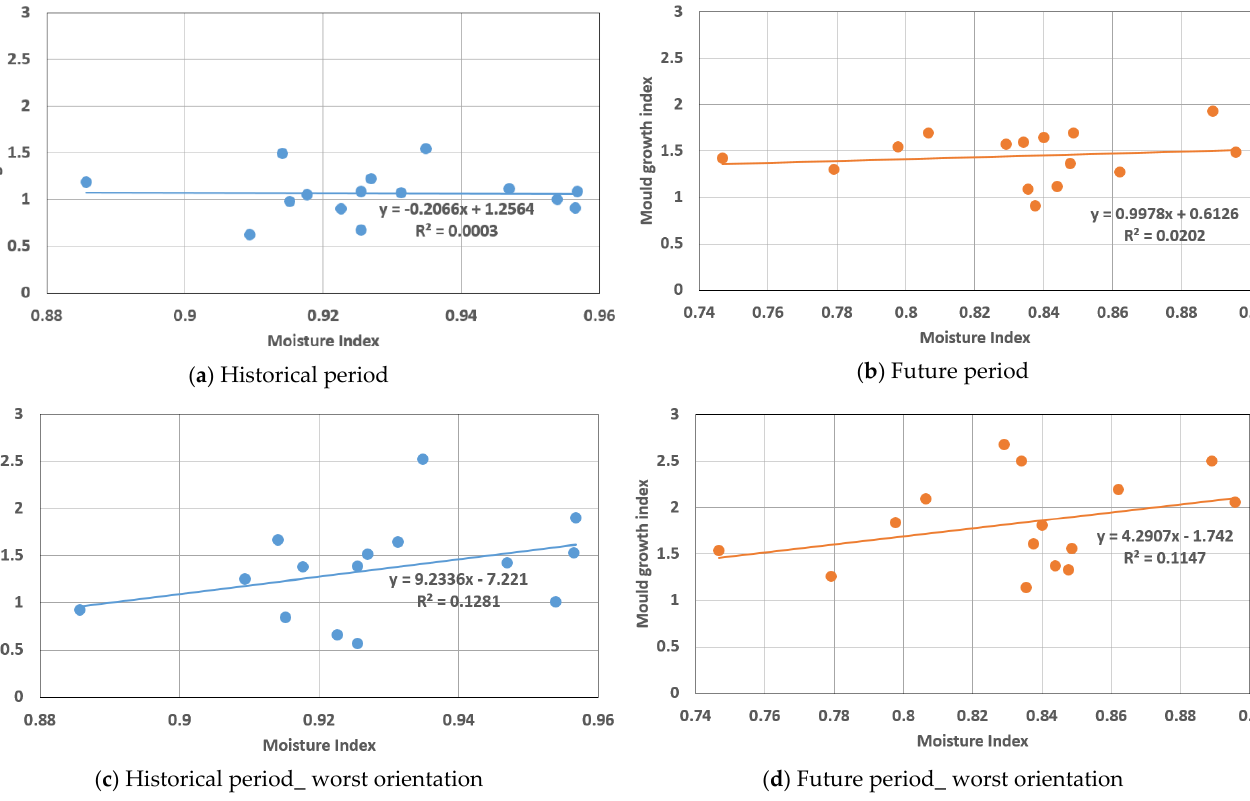
Figure 14. Mould growth index (mean value of 2-year’s average) as a function of moisture index.